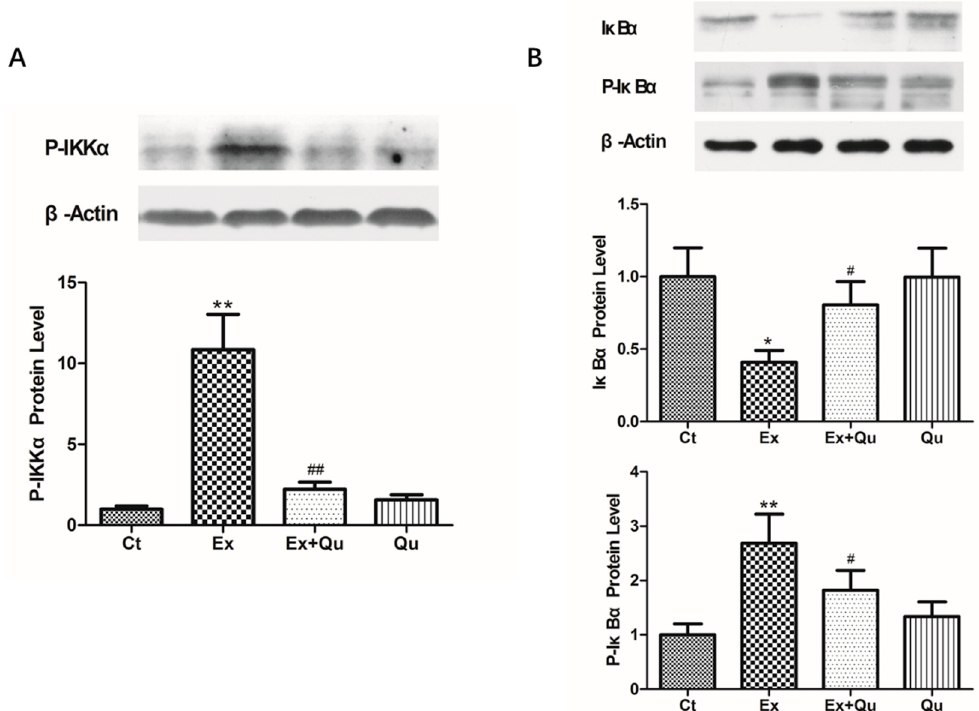
Figure 5. Phosphorylated protein level of IKK α ( A ), I κ B α and P-I κ B α ( B ) in mice liver exposed to intensive running with or without quercetin pretreatment. Figures show representative western blot (upper panel) and densitometric analysis (lower panel). Data presented as fold-change compared